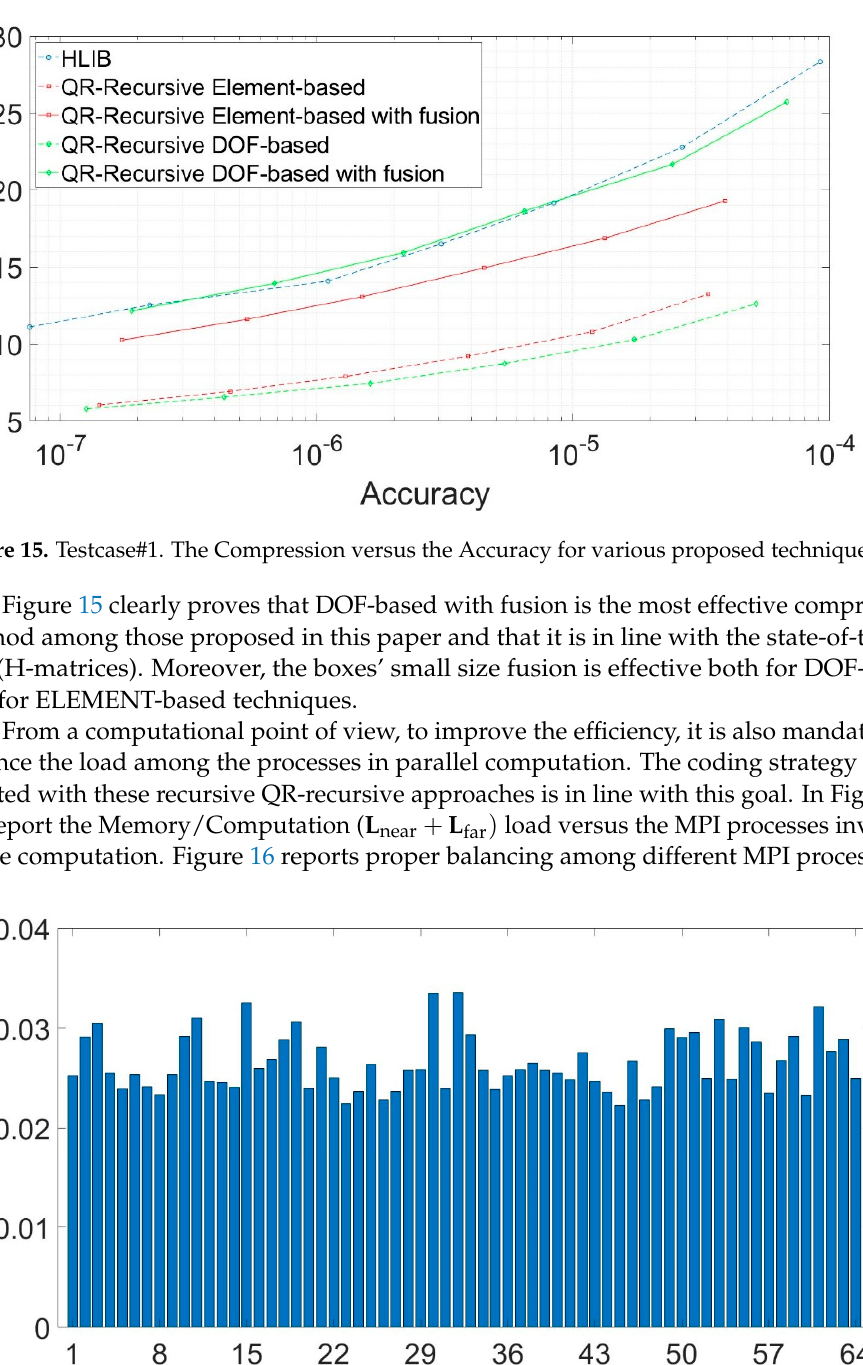
Figure 16. Testcase#1. The Memory/Computation load versus MPI processors used in computa- tion.